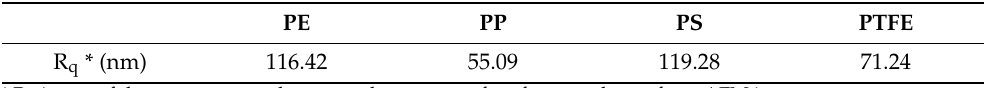
Table 2. Analysis of surface roughness of microplastic beads by AFM. PE PP PS